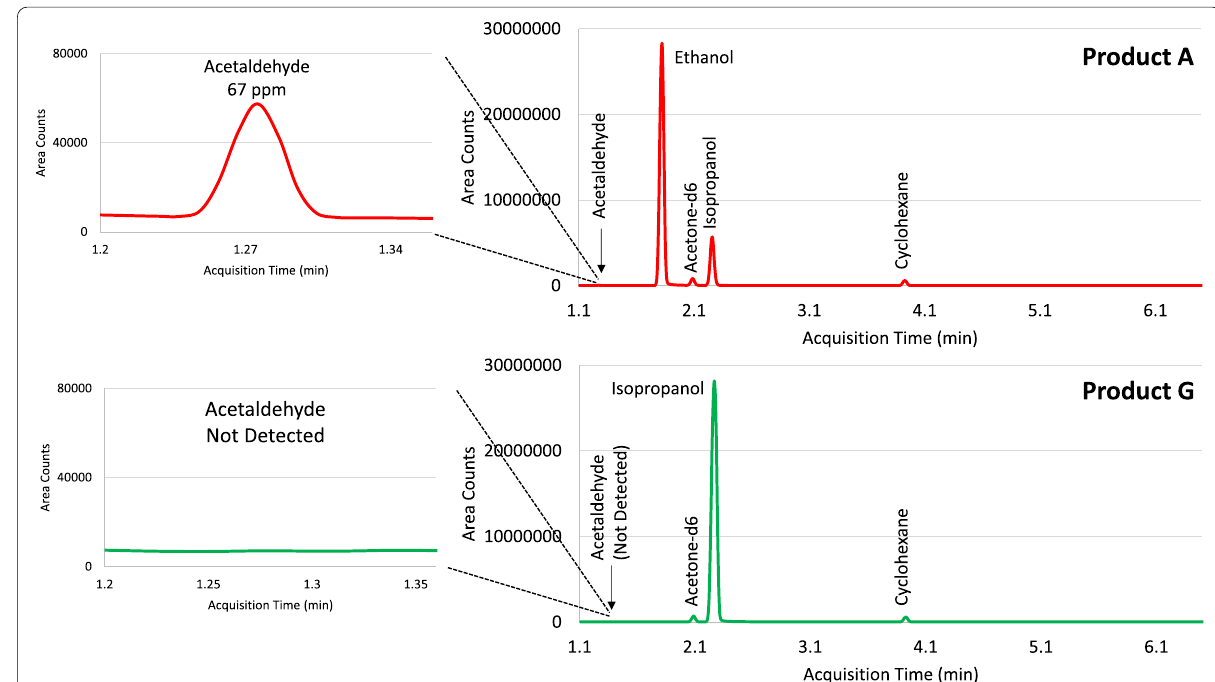
Fig. 3 Chromatogram of product A with acetaldehyde detected above the concentration limit and product G with no acetaldehyde detected*. *The top chromatograms in red represent product A and the bottom chromatograms in green represent product G. The chromatograms on the left are scaled so that the acetaldehyde impurity could be visualized. The chromatograms on the right are scaled to the peak of the active